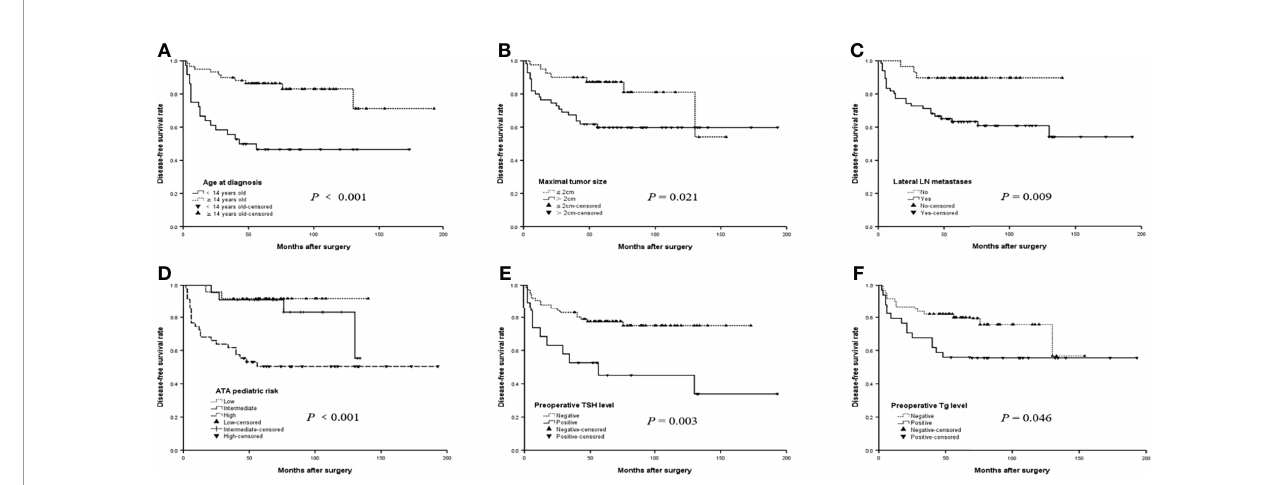
FIGURE 1 | The disease-free survival (DFS) curves of risk factors for recurrence in children and adolescents with papillary thyroid carcinoma (PTC). (A) The DFS curves of age at diagnosis in children and adolescents with PTC. (B) The DFS curves of maximal tumor size in children and adolescents with PTC. (C) The DFS curves of lateral LN metastases in children and adolescents with PTC. (D) The DFS curves of ATA pediatric in children and adolescents with PTC. (E) The DFS curves of Preoperative TSH level in children and adolescents with PTC. (F) The DFS curves of Preoperative Tg level in children and adolescents with PTC.